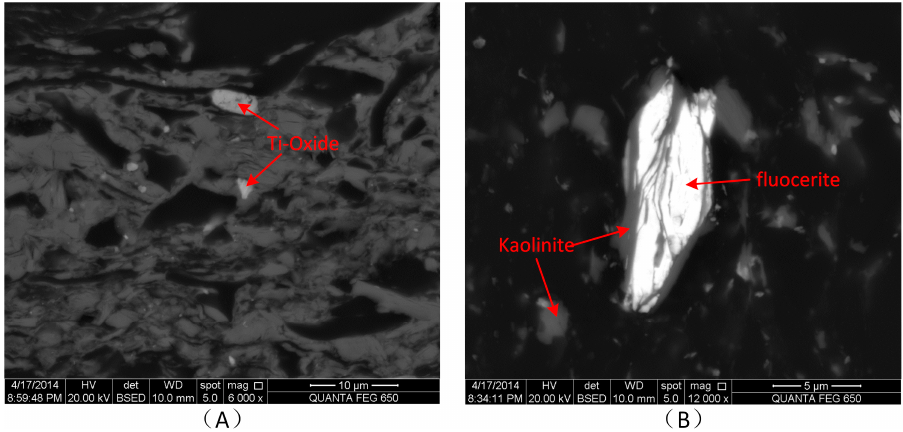
Figure 8. Back-scattered electron images of ( A ) Ti-oxide and ( B ) fluocerite in C25-3. Chalcopyrite, titaniferous magnetite, apatite, and Ti-augite are present only in roof sample C19-r. Chalcopyrite occurs as fracture fillings (Figure 9A). Barite occurs in the form of discrete particles (Figure 9B). Titaniferous magnetite occurs as irregular granular. Apatite occurs as acicular idiomorphic crystals (Figure 9C). Ti-augite and rare magnetite occur as phenocrysts (Figure 9D). Marcasite was observed by SEM-EDS analysis in sample C25-f (Figure 10).